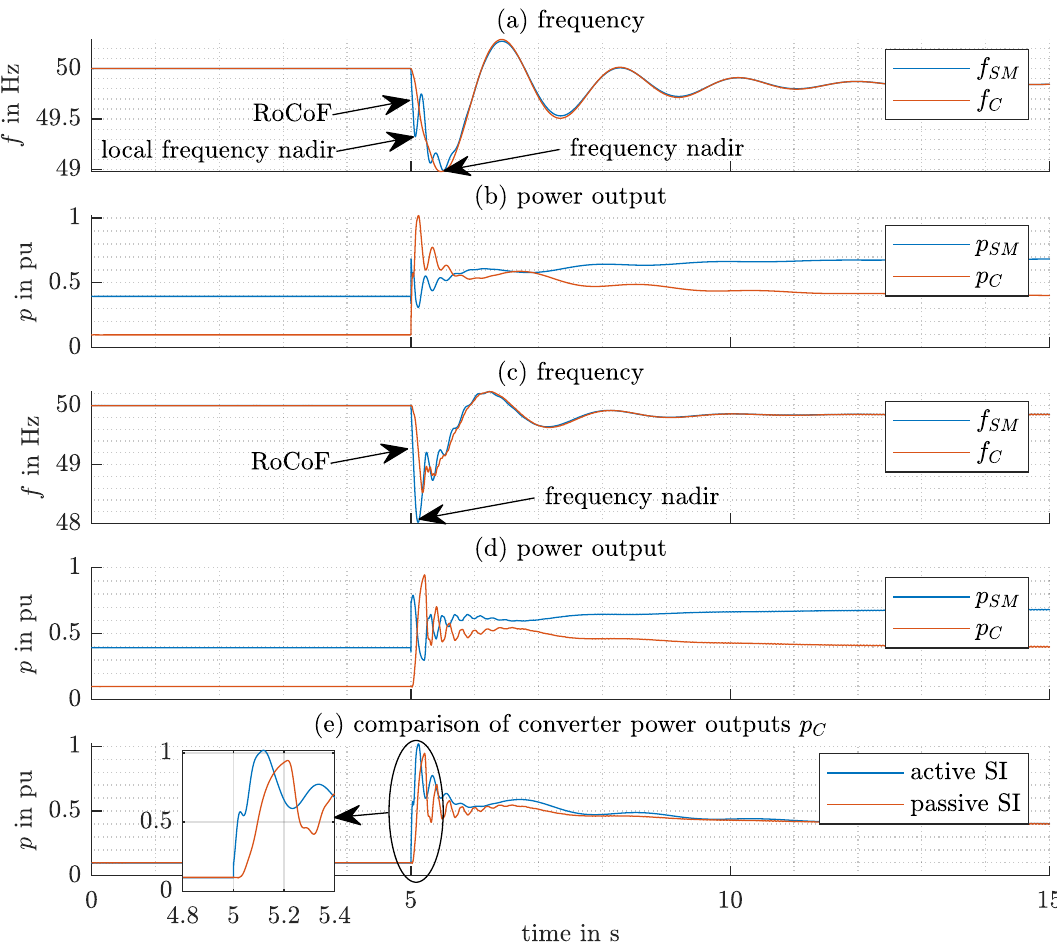
Figure 9. Simulation results of a load-step in the Microgrid shown in Figure 8 in case active synthetic inertia is used in ( a , b ) and passive synthetic inertia is used in ( c , d ). ( a , c ) each show the frequency of the synchronous machine f SM and the converter f C , ( c , d ) each show the normalized power output of the synchronous machine p SM and the converter p C . ( e ) compares the converter power outputs for active- and passive synthetic inertia where the relevant time range is zoomed out in an additional